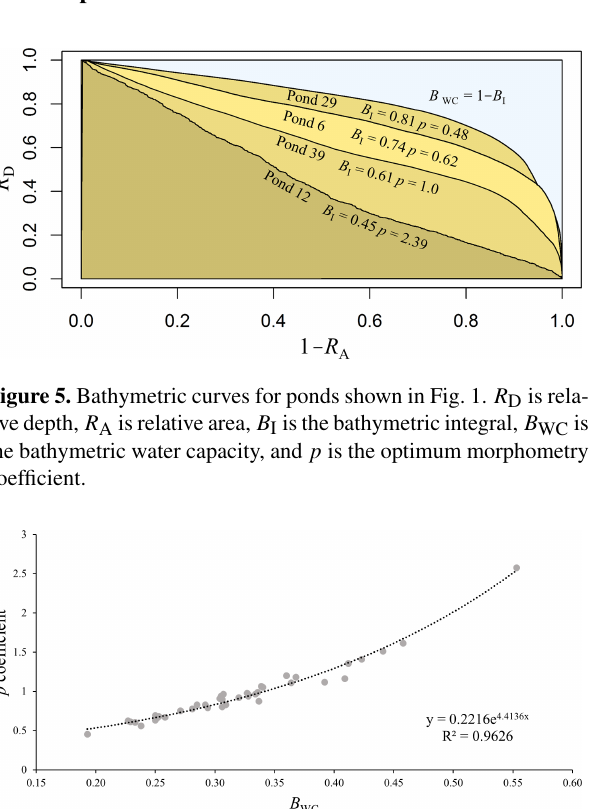
Figure 6. Relationship between the morphometry ( p ) coefficient (full model) and the bathymetric water capacity ( B WC